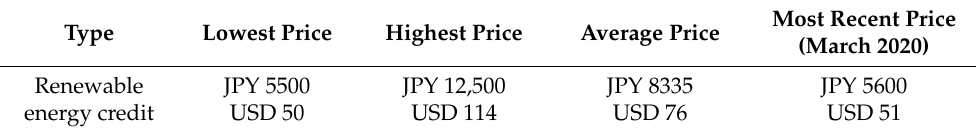
Table 2. Trading price for carbon credits 1 (unit: USD/t-CO 2 ; based on [46]). Type Lowest Price Highest